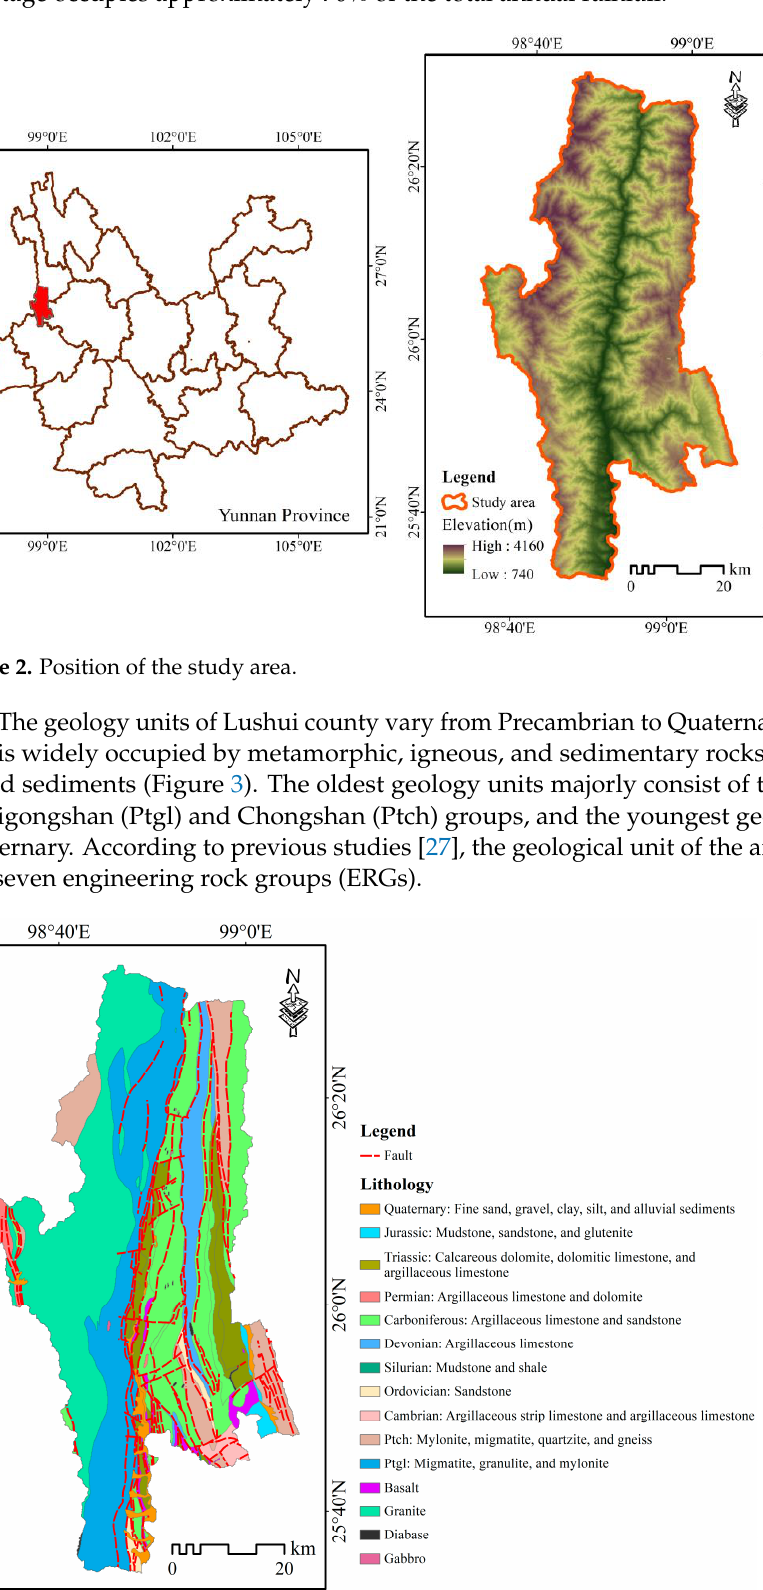
Figure 3. Geological map of the study